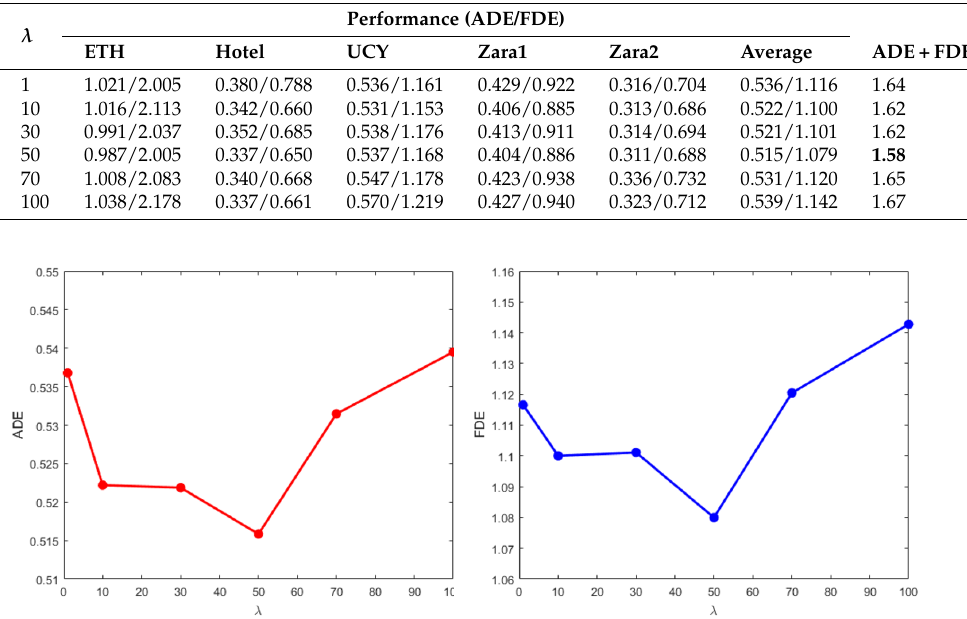
Figure 4. Results comparison of average ADE ( left ) and FDE ( right ) on different values of the key parameter λ . With the increase of λ , the performance keeps getting better steadily until up to 50 when starts to deteriorate. λ is set as 50, which is often sufficient to achieve very good results on pedestrian forecasting.